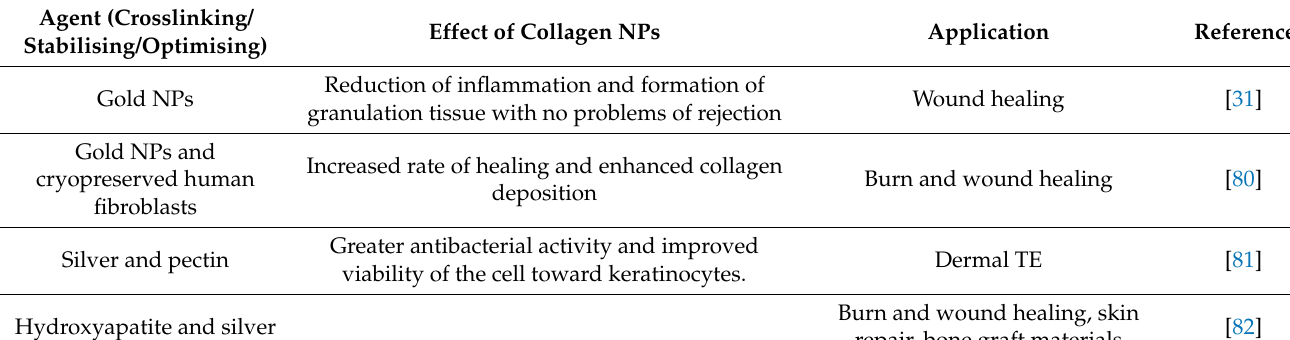
Table 3. Investigations on Collagen NPs in